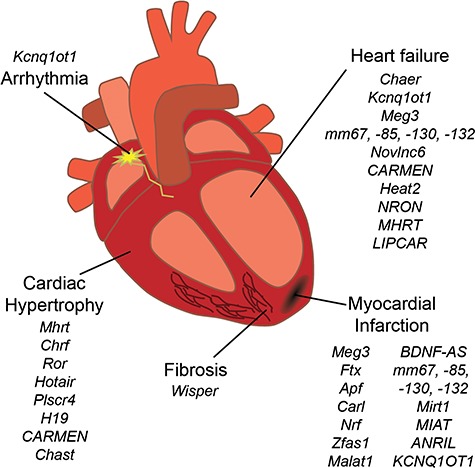
Prevalent CVDs in the aging heart and lncRNAs associated to them.